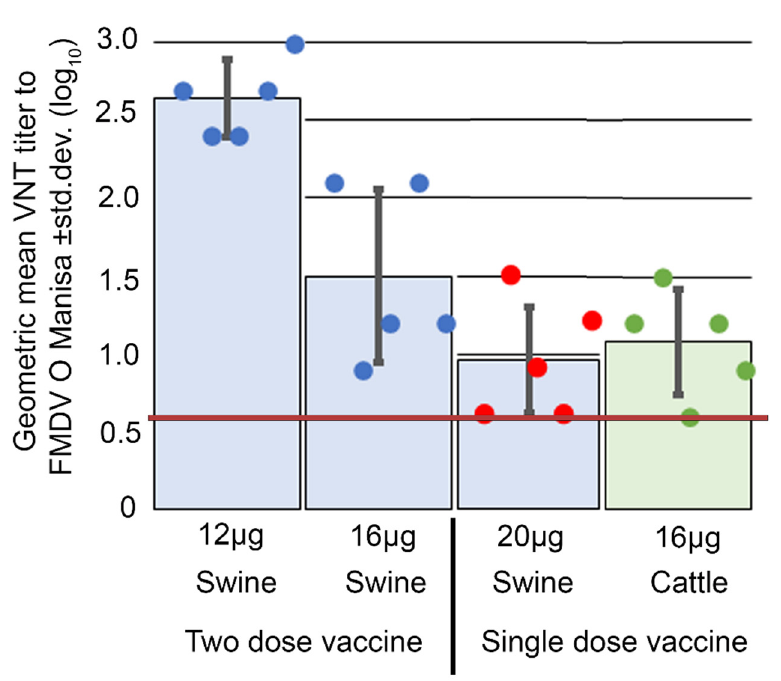
Figure 3. VNTs at the time of challenge for treatment groups and individuals. The mean VNTs for swine treatment groups, 12 µ g, 16 µ g, and 20 µ g, are presented in blue, while the mean VNTs for the 16 µ g cattle group are presented in green. Protected swine are represented by blue circles, protected cattle are represented by green circles, and unprotected swine represented are represented by red circles, all grouped by treatment. Baseline VNTs observed in unvaccinated animals, both swine and cattle, are 0.6 and represented by a red line. Table 2. Detection of antibodies to FMDV nonstructural proteins utilizing 3B ELISA in post- vaccination/pre-challenge and post-challenge vaccinated cattle. Positive values categorized as inhibition ≥